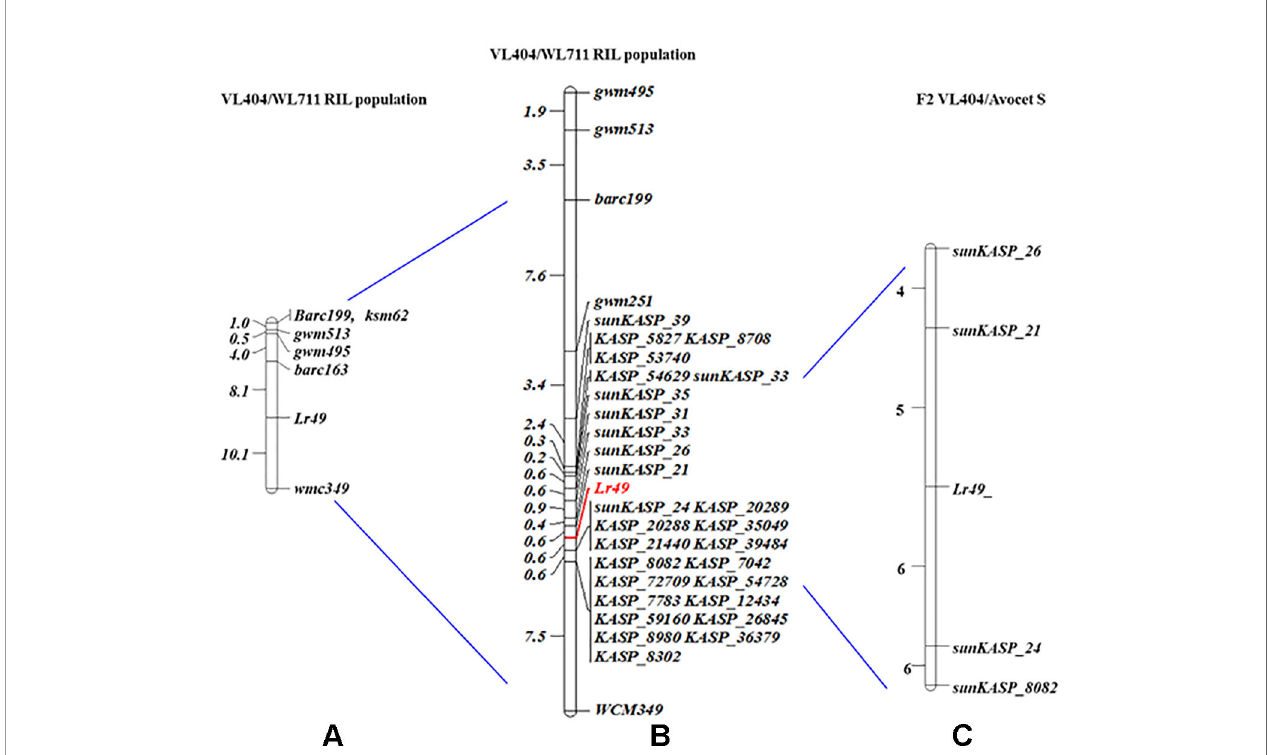
FIGURE 1 | Genetic linkage map of chromosome 4BL for the VL404/WL711 RIL population (A) Bansal et al. (2008), (B) present study (resistance gene is shown in red text), and (C) high resolution map of VL404/Avocet S (number of recombinants is given on the